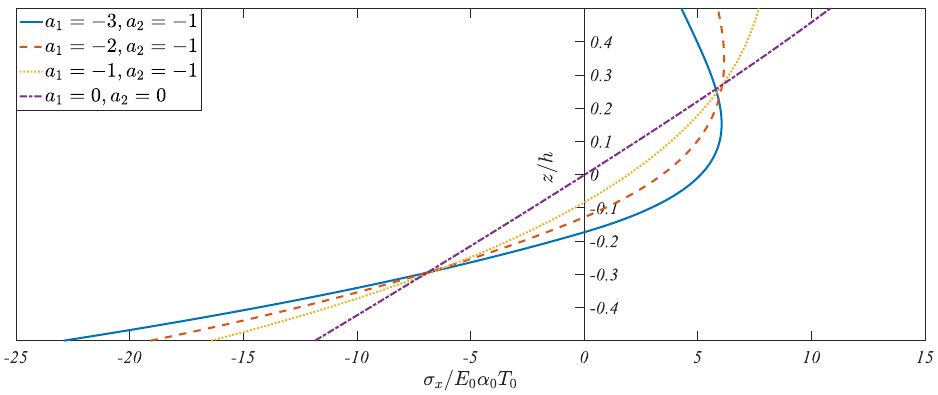
0 e z/h and M/bh 2 = 2 E 0 α 0 T 0 .